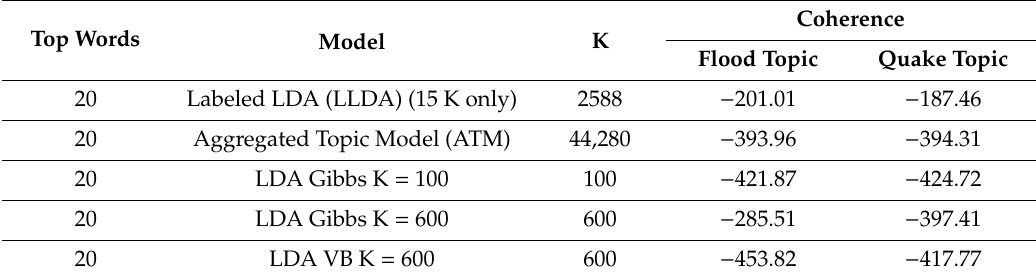
Table 10. Topic coherence metric from topic models (lower coherence score is